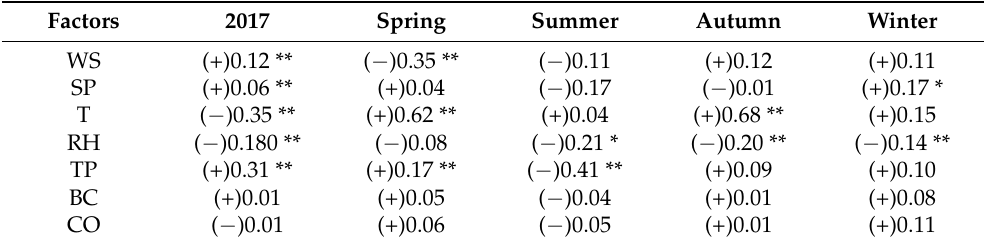
Table 5. The q statistics and correlation direction of the factors driving O3 concentration in the GBA. Positive and negative signs in parentheses represent the direction of the correlation.